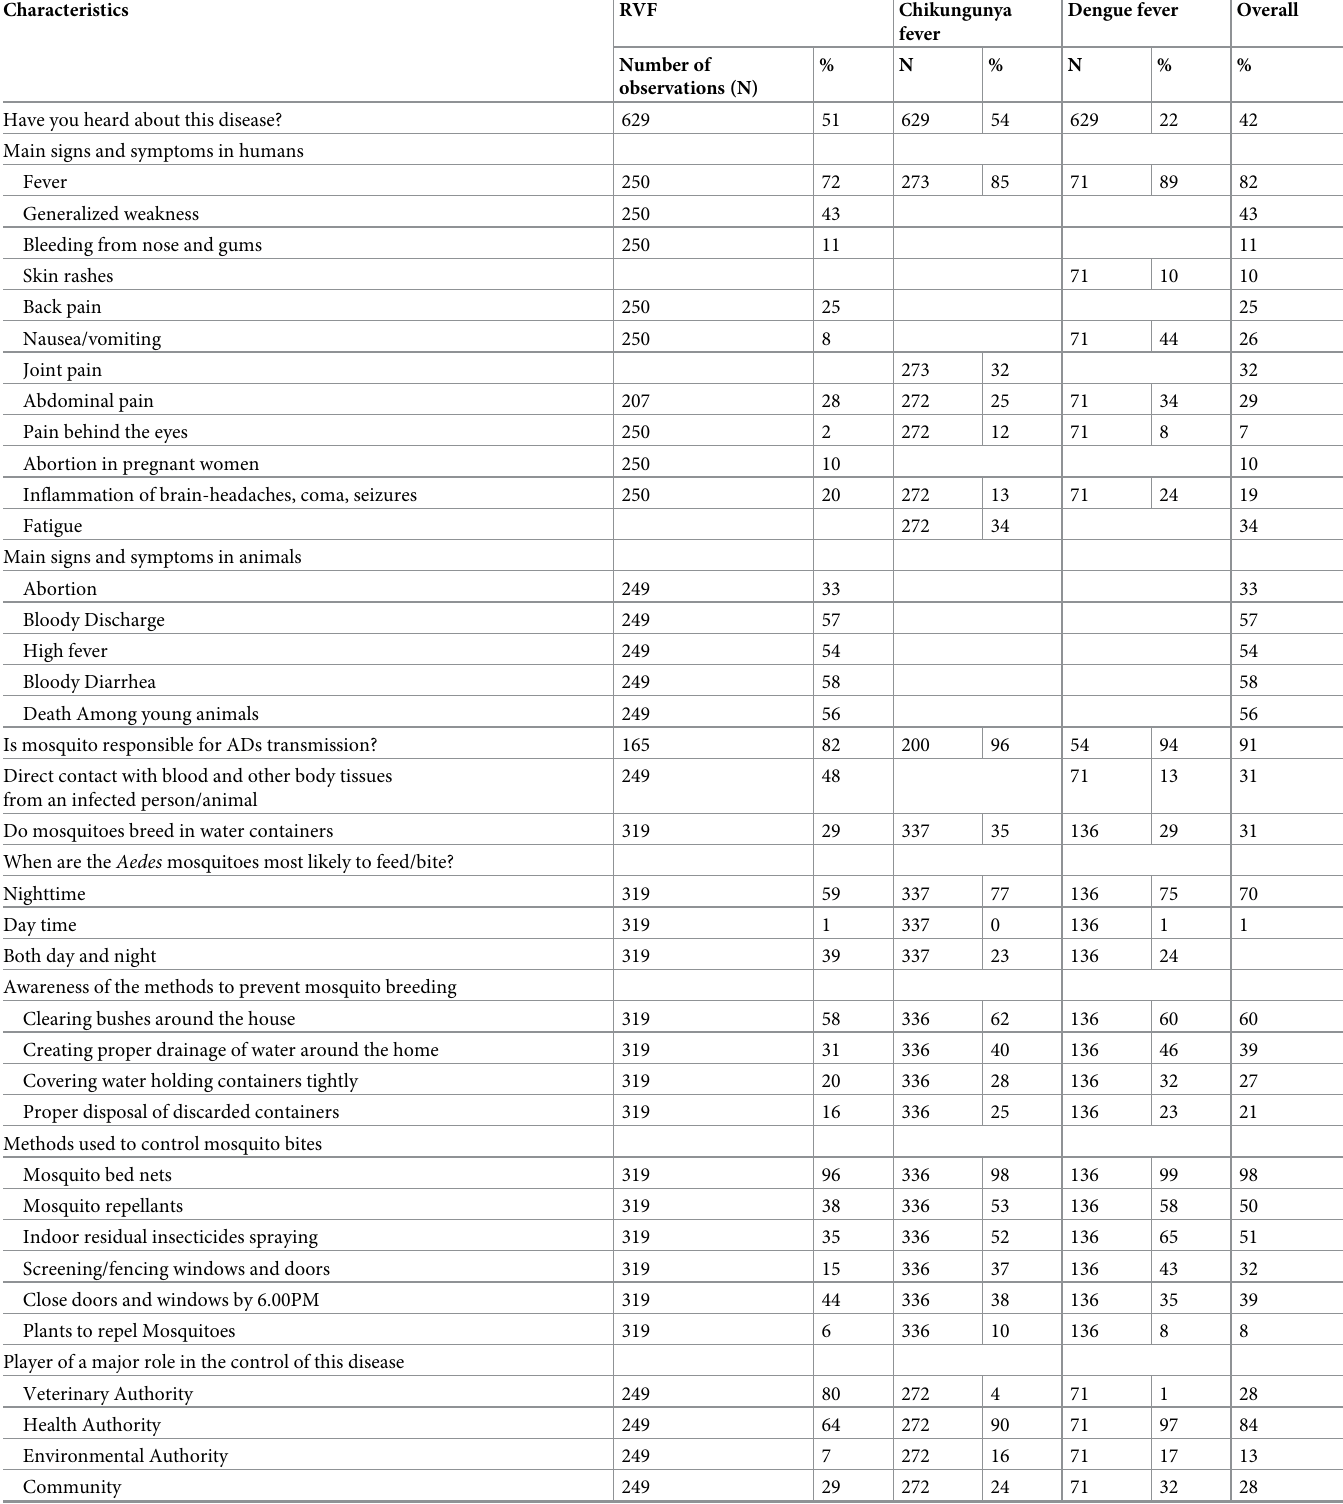
Table 3. Farmers knowledge of signs, symptoms, transmission methods, beliefs and management of ADs in Kenya.